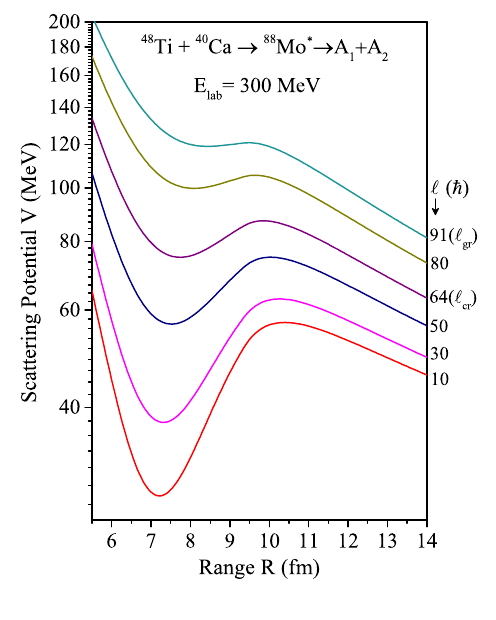
Figure 4. Variation of interaction potential V(R) (sum of V P , V C and V (cid:96) ) as function of range at di ff erent (cid:96) -values for β 2 -deformed choice of